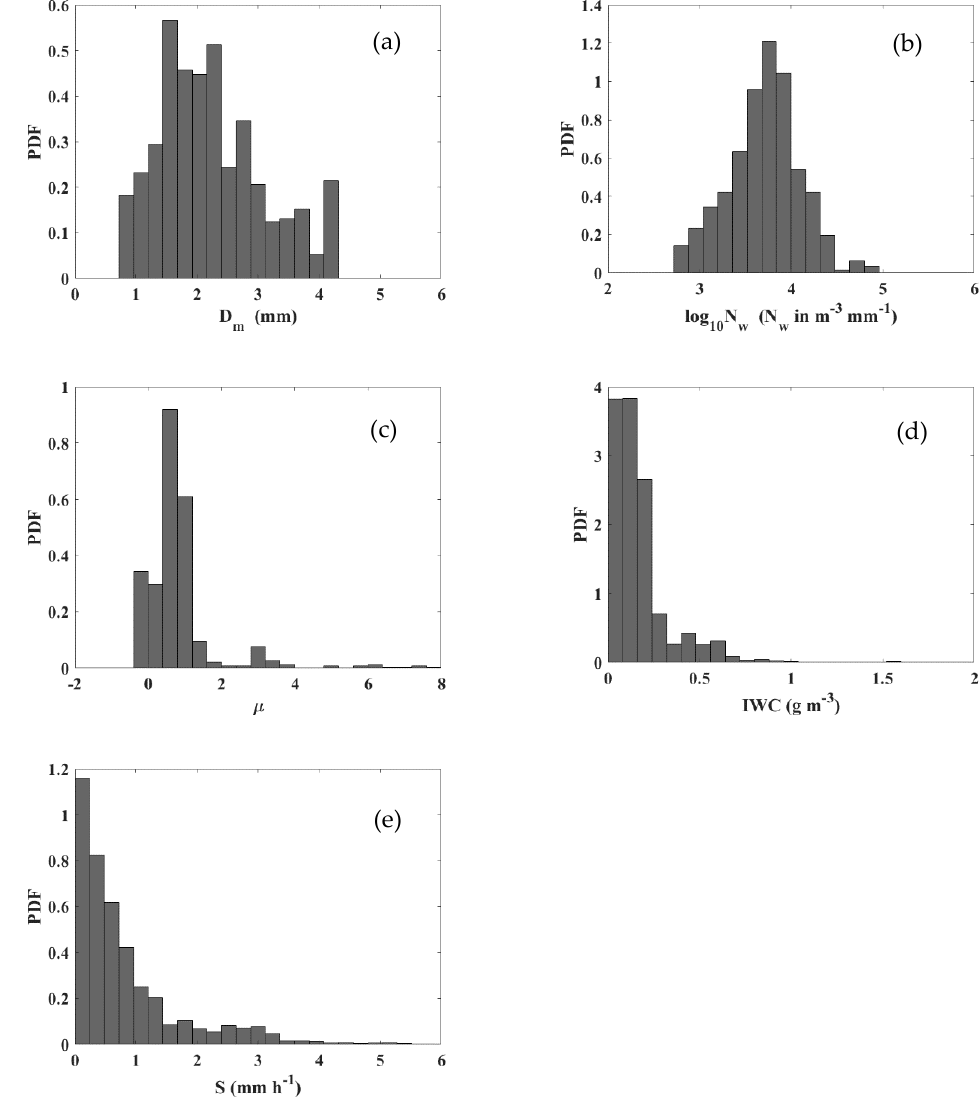
Figure 8. Histograms of microphysical parameters retrieved using RF methods for total snowfall cases: ( a ) volume-weighted diameter D m , ( b ) normalized intercept parameter, log 10 N w , ( c ) shape factor µ, ( d ) ice water content IWC, and ( e ) snowfall rate.